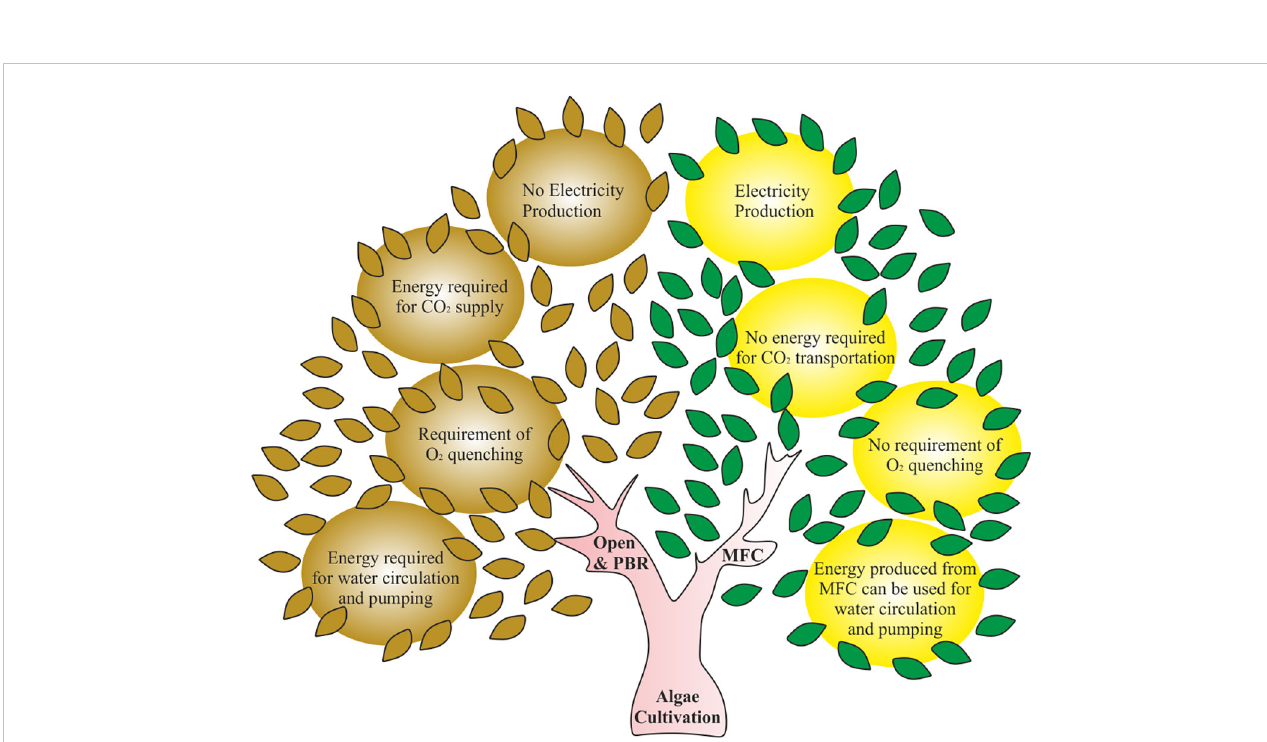
FIGURE 1 Illustration showing the comparison between conventional algae cultivation systems and microbial fuel cell based algae cultivation. PBR, Photobioreactor and MFC, Microbial fuel